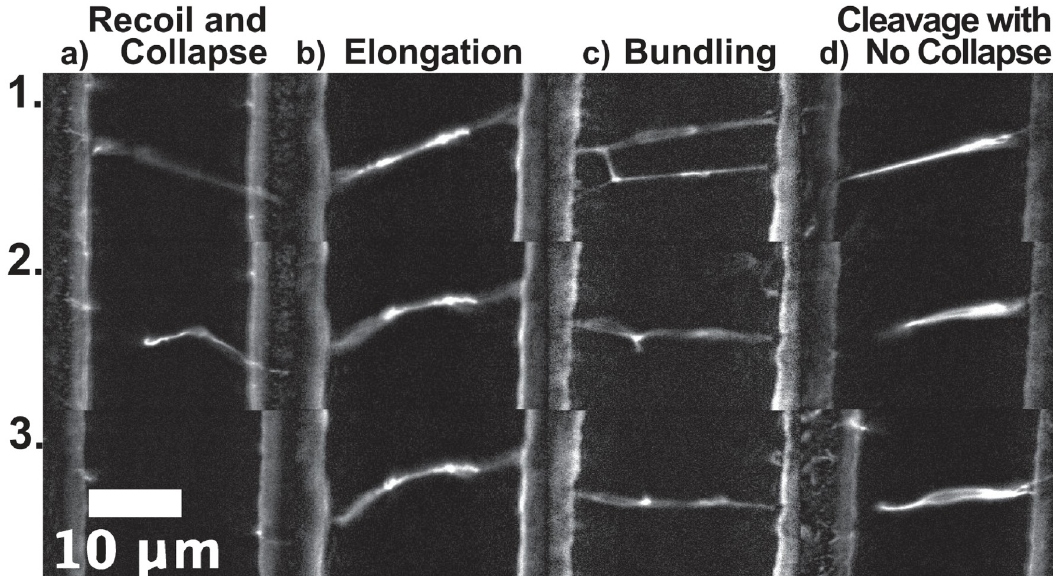
Fig 1. Representative Time Series of Observed Fibrinolytic Outcomes: Each image on top (panel 1) displays the fiber’s initial conformation. Time increases as the image series progresses downwards. Final frames are shown in panel 3. Distinct image series show a) fibers are cleaved, recoil, and collapse (See S1 Movie); b) fibers remain uncleaved and elongate (See S2 Movie); c) one fiber is cleaved and bundles with another intact fiber (See S3 Movie); and d) fibers are cleaved but do not collapse (See S4